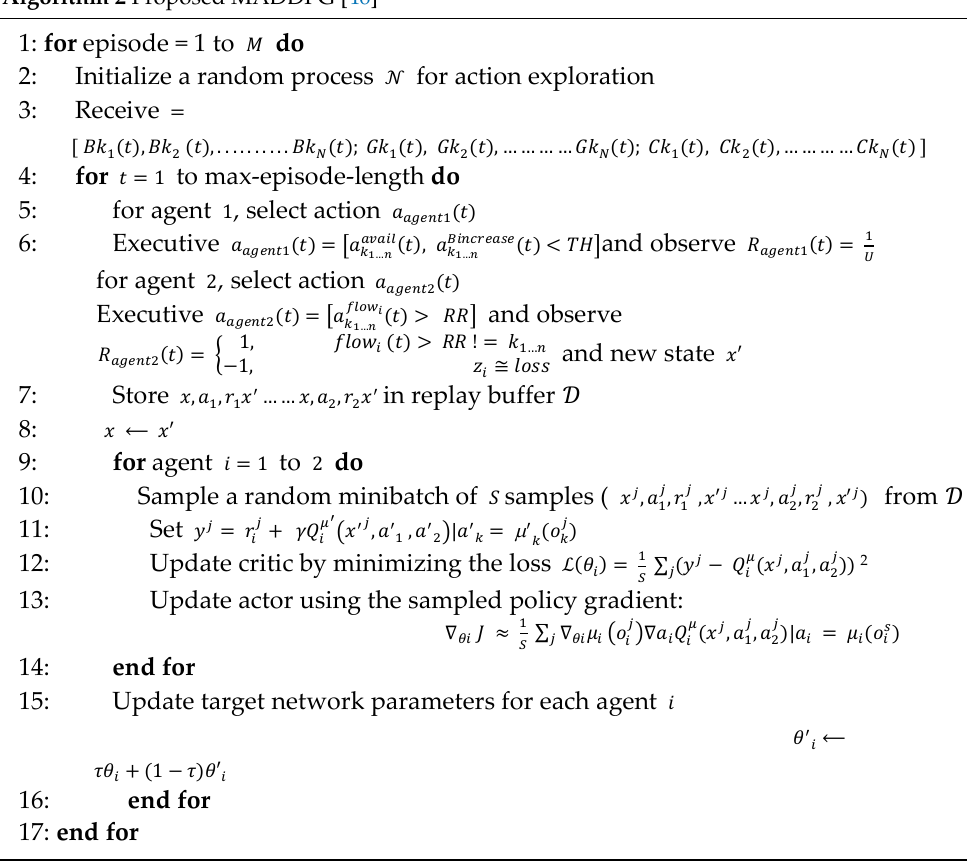
Figure 8. MARL MADDPG flow